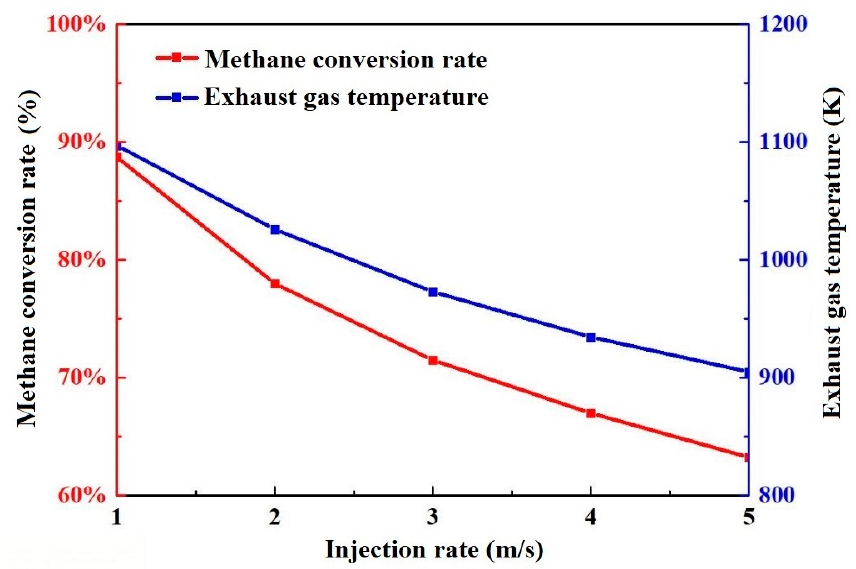
Figure 20. The influence of injection rate on conversion rate and exhaust gas temperature at 4 MPa,